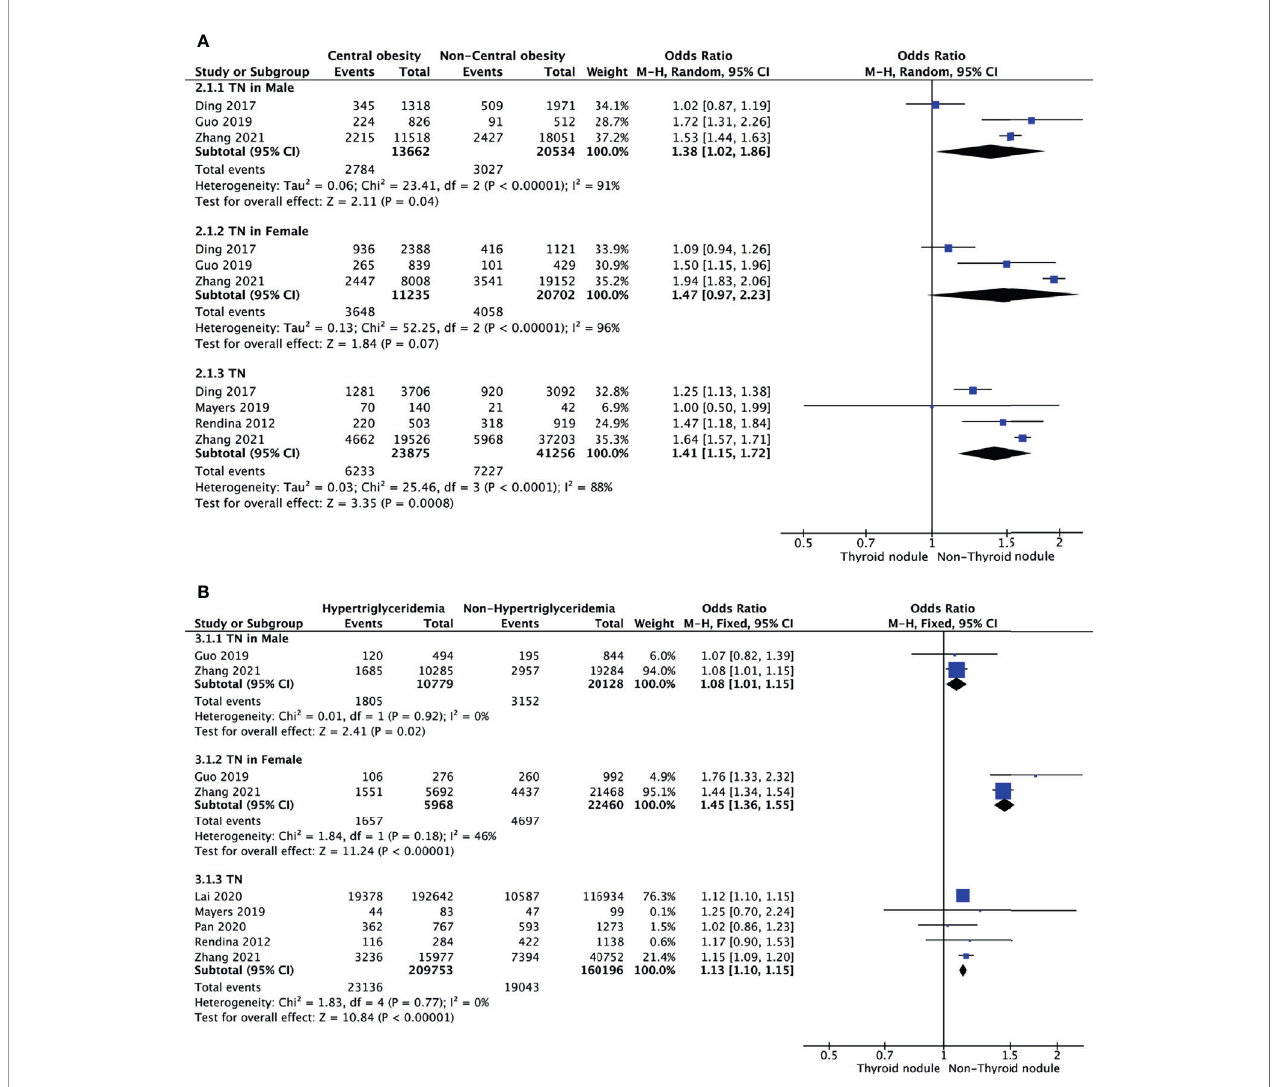
FIGURE 3 | Forest plots of the association among central obesity (A) , hypertriglyceridemia (B) , and